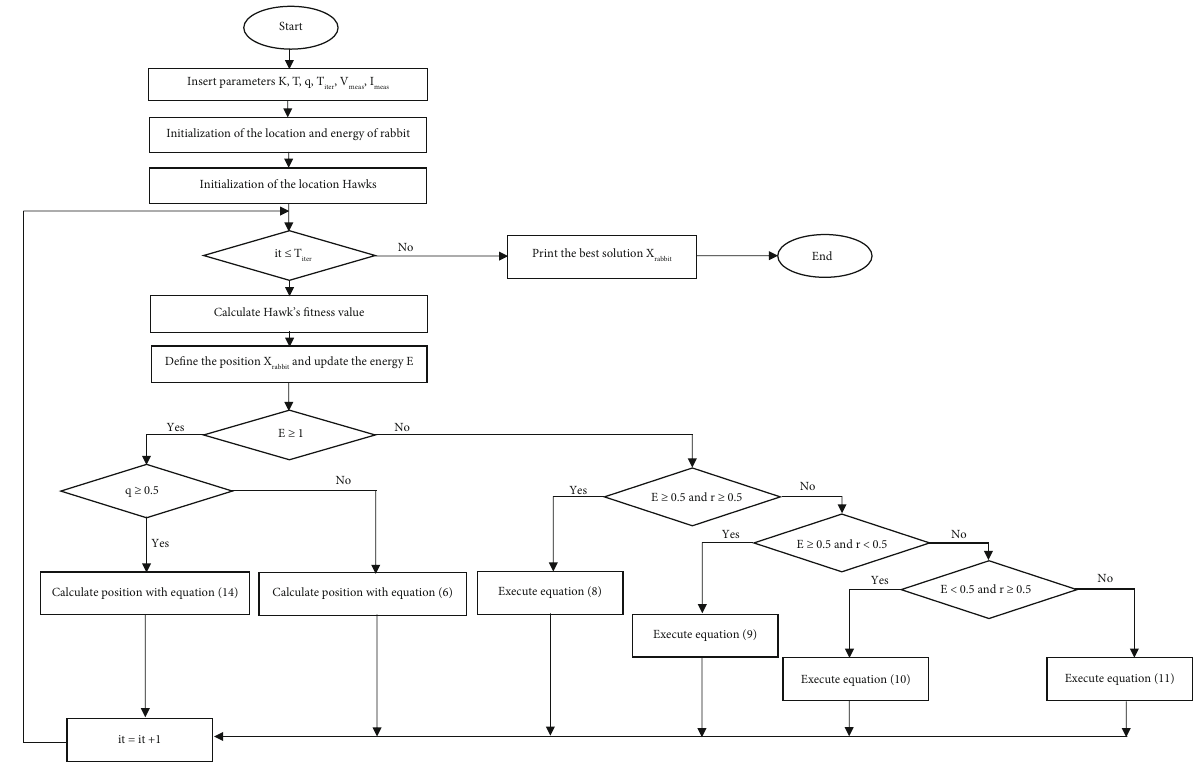
Figure 3: Flowchart HHODE Table 1: Parameters boundaries of this operation.